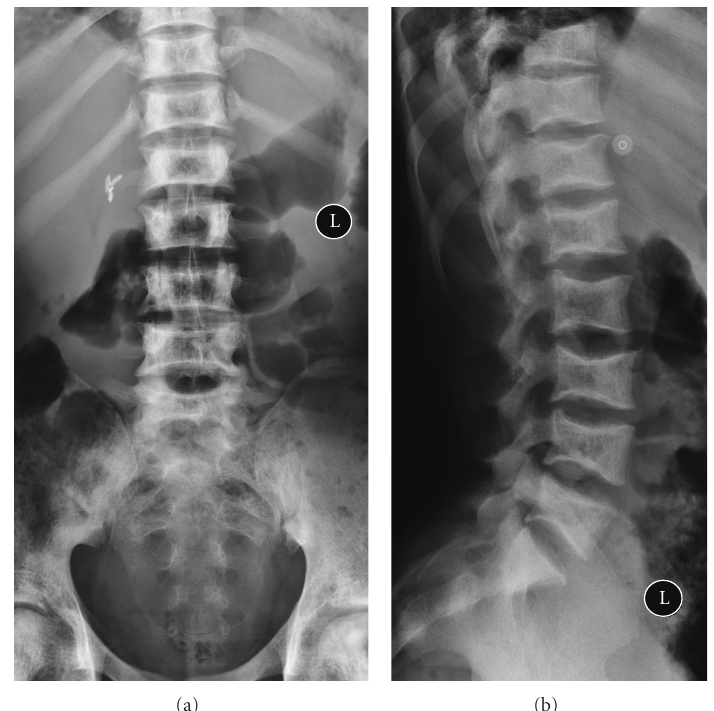
Figure 11: (a) and (b) AP and lateral plain radiographs of the lumbar spine showing sharp end plate depressions due to central end-plate infarction resulting in classic H-shaped vertebrae. On the other hand bone softening results in smooth concavity described as fish mouth vertebra. Also note cholecystectomy clips from previous surgery for pigmented stones and patchy sclerosis of the pelvic bones from medullary